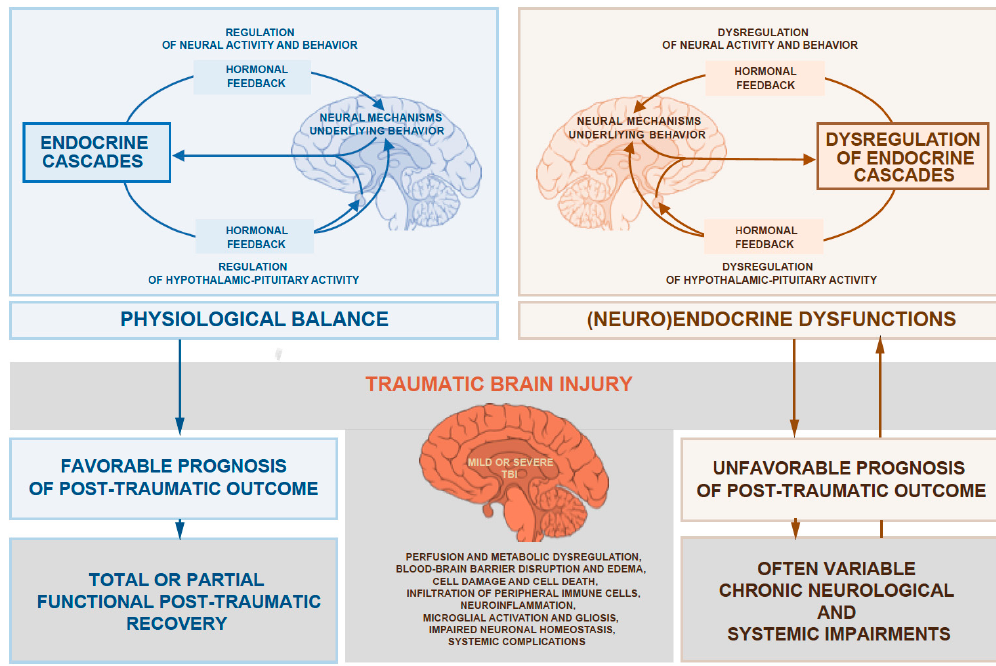
Figure 1. The relations schematic shows the concept of a cause-and-effect relationship between the outcome of traumatic brain injury (TBI) and a preexisting (neuro) endocrine state that appears to be involved in many, if not most, of the substantial problems leading to elevated risk for poor outcome in traumatic brain injury.